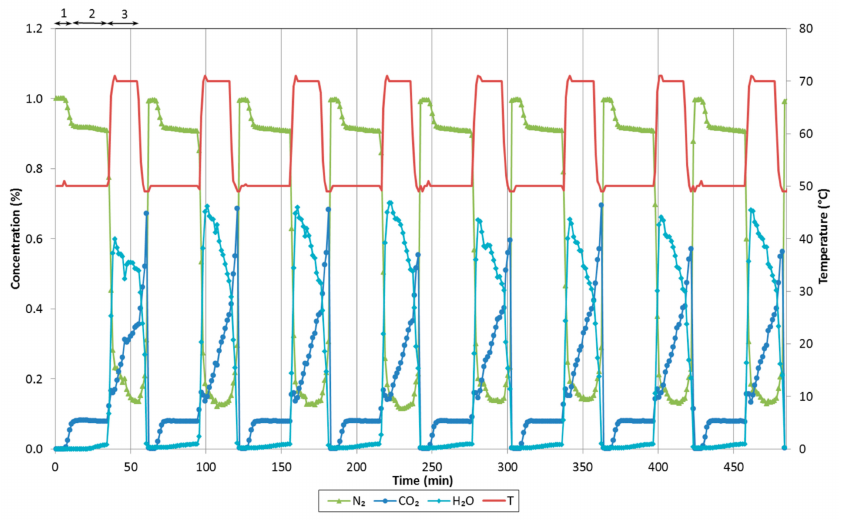
Figure 6. Example of eight adsorption–desorption cycles at 50 ◦ C for a mixture of 8/90/2 vol % CO 2 /N 2 /H 2